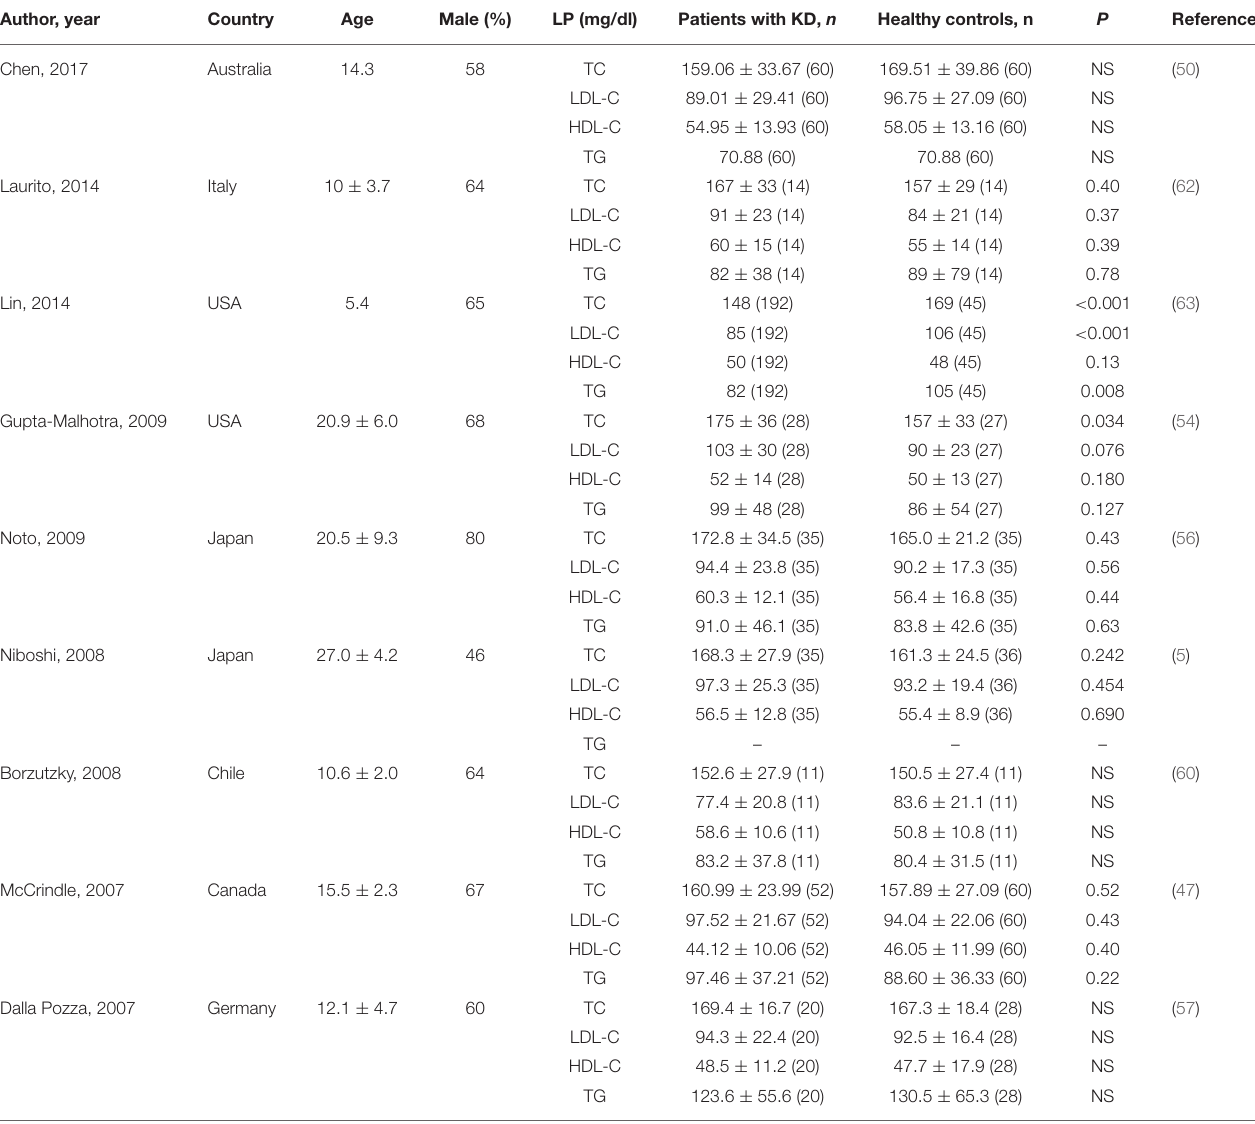
TABLE 3 | Studies on lipid profile in patients with a history of